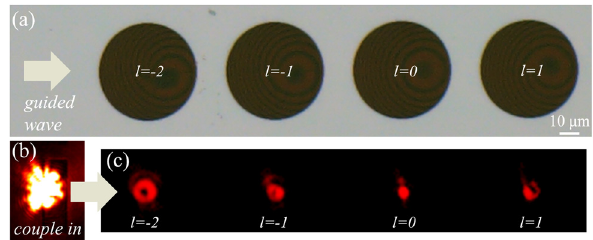
Figure 5: Experimental demonstration of the cascaded focused OAM emitter array. (a) Optical microscopic image of the fabricated array consists of four emitterswithdifferent l = − 2, − 1,0,1.Inexperiments,TE 0 guidedwave is excited and propagates from left to right. (b) Illumination onto the couple-in grating at λ 0 = 1550 nm. (c) Simultaneously measured in- tensity patterns on the focal plane emitted from the array. The im- perfectionsmay be due tothe diffractioneffectinsidethe